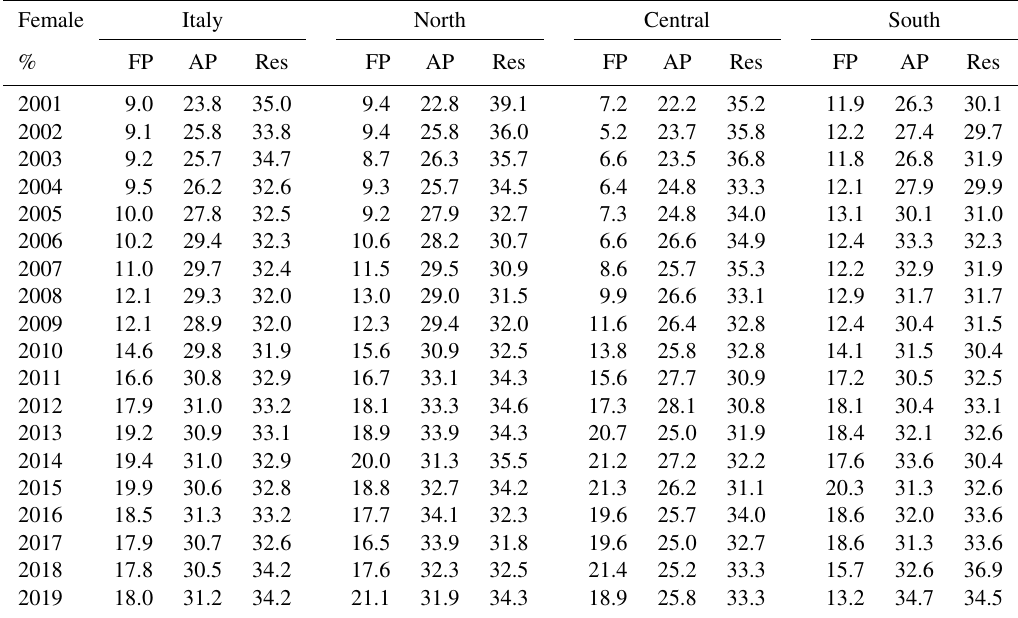
Figure 5. Proportion (%) of female academic staff (F. P.: full professors; A. P.: associated professors and Res: Researchers) from 2001 to 2019 in (a) Northern; (b) Central; (c) Southern Italy; (d) whole Italy, (data source: MIUR, https://cercauniversita.cineca.it/php5/docenti/cerca.php, last access: 31 October 2019). Table 5. Geographical distribution (%) of female professors over Northern (N including Aosta Valley, Emilia-Romagna, Friuli Venezia Giulia, Liguria, Lombardy, Piedmont, and Veneto), Central (C including Lazio, Marche, Tuscany ed Umbria) and Southern (S including Abruzzo, Basilicata, Calabria, Campania, Molise, Puglia, Sardinia and Sicily) Italy from 2001 to 2019. National data are also provided for comparison (data source: MIUR, https://cercauniversita.cineca.it/php5/docenti/cerca.php, last access: 31 October 2019). Female Italy North Central